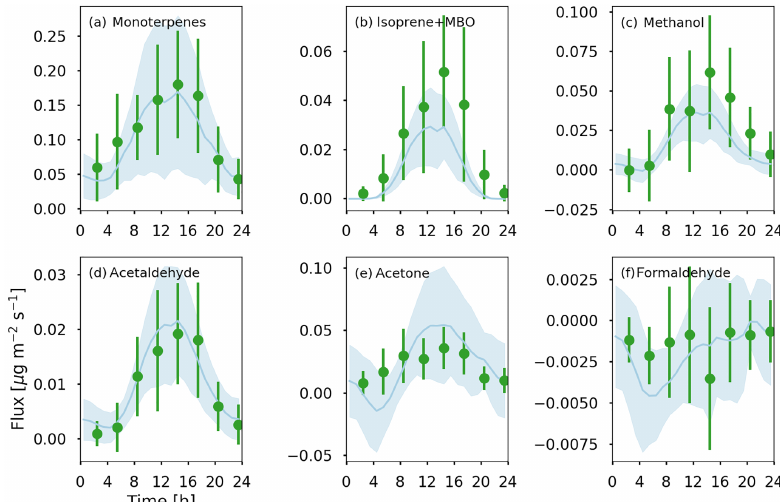
Figure 4. Modelled (blue lines) and measured (green points) monthly-averaged diurnal cycles of fluxes for (a) monoterpenes, (b) iso- prene + MBO, (c) methanol, (d) acetaldehyde, (e) acetone, and (f) formaldehyde at the canopy top. The ranges of ± 1 standard deviation for modelled and measured data are marked by shaded areas and vertical lines, respectively. The x labels and y labels of (d) also apply to all the other